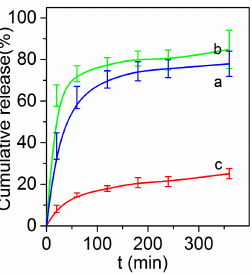
Figure 5. Cumulative release of hydrocortisone drug in a simulated gastric fluid from the microparticles obtained at a drying temperature of 155 °C with an ethanol/water mixed solvent of 1:4 ( a ); 1:1 ( b ); and 4:1 ( c ) volume ratio, respectively. The above different release behaviors are directly associated with the different structures of the